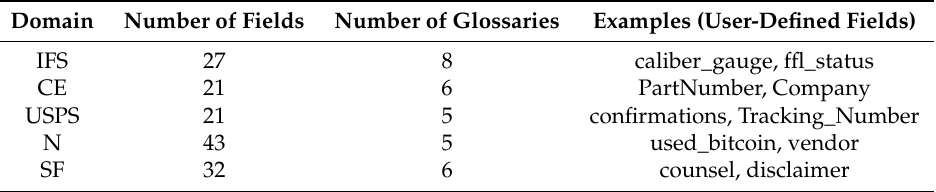
Table 1. Quantifying user effort in terms of total numbers of fields and glossaries per domain, after the users had finished setting up their respective